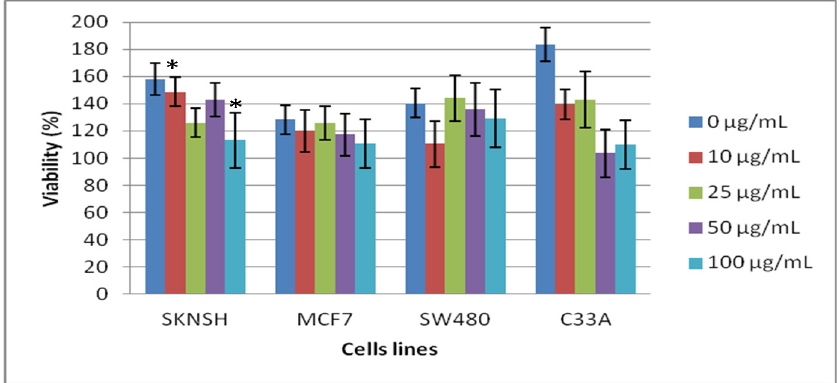
Figure 4. Cytotoxicity of lectin after 24 h, during which lectins were removed from the cells employing the 3-(4,5-dimethylthazol-2-yl)-2,5-diphenyltetrazolium bromide (MTT) cell assay. The cells were previously incubated for 24 h with the lectin solution; then, the solutions were removed and the cells were incubated for 24 h only with cell culture solutions [Dulbecco’s modified Eagle’s medium (DMEM) and fetal bovine serum (FBS)]. All values are expressed as mean ± SEM of three independent